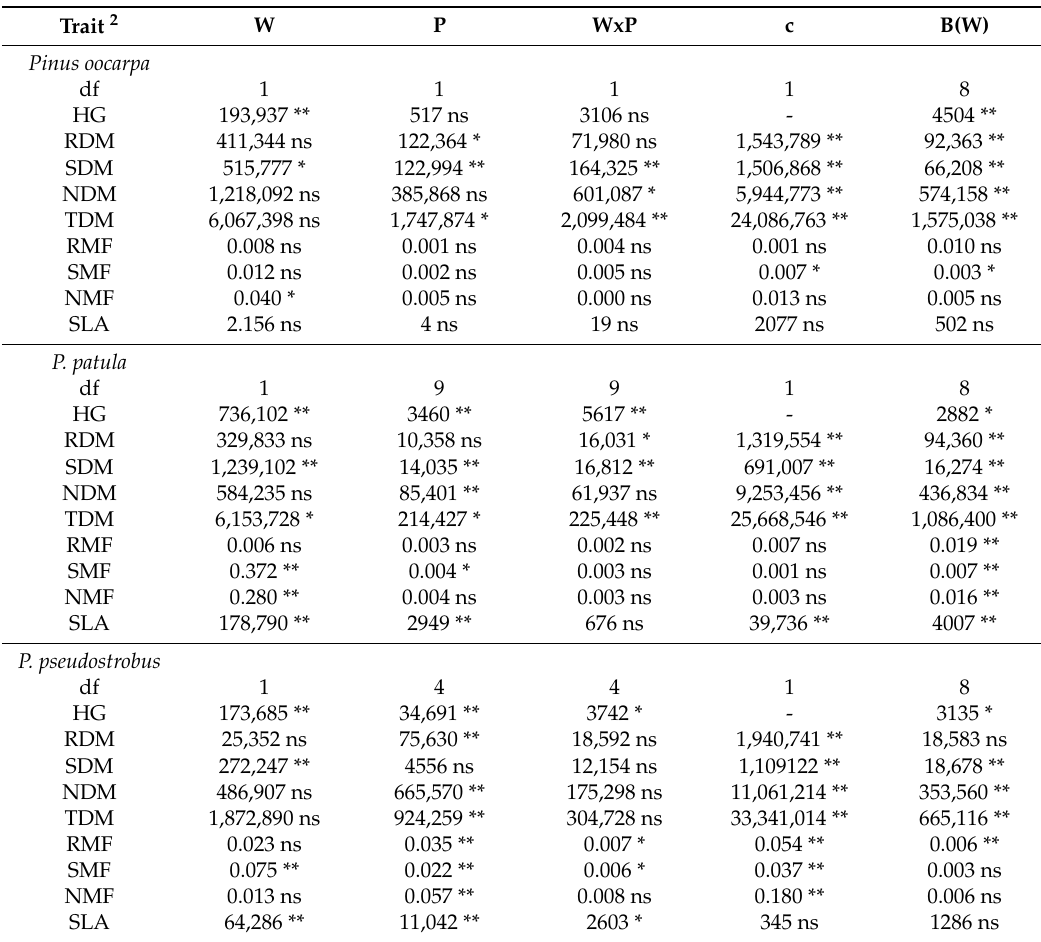
Table 3. Mean squares and level of significance 1 in the intra-specific analysis per species for different functional traits in three Mexican pines.